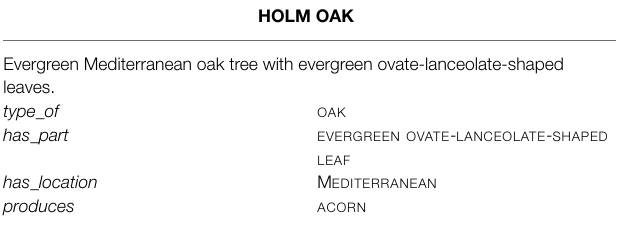
TABLE 3 | holm oak definitional